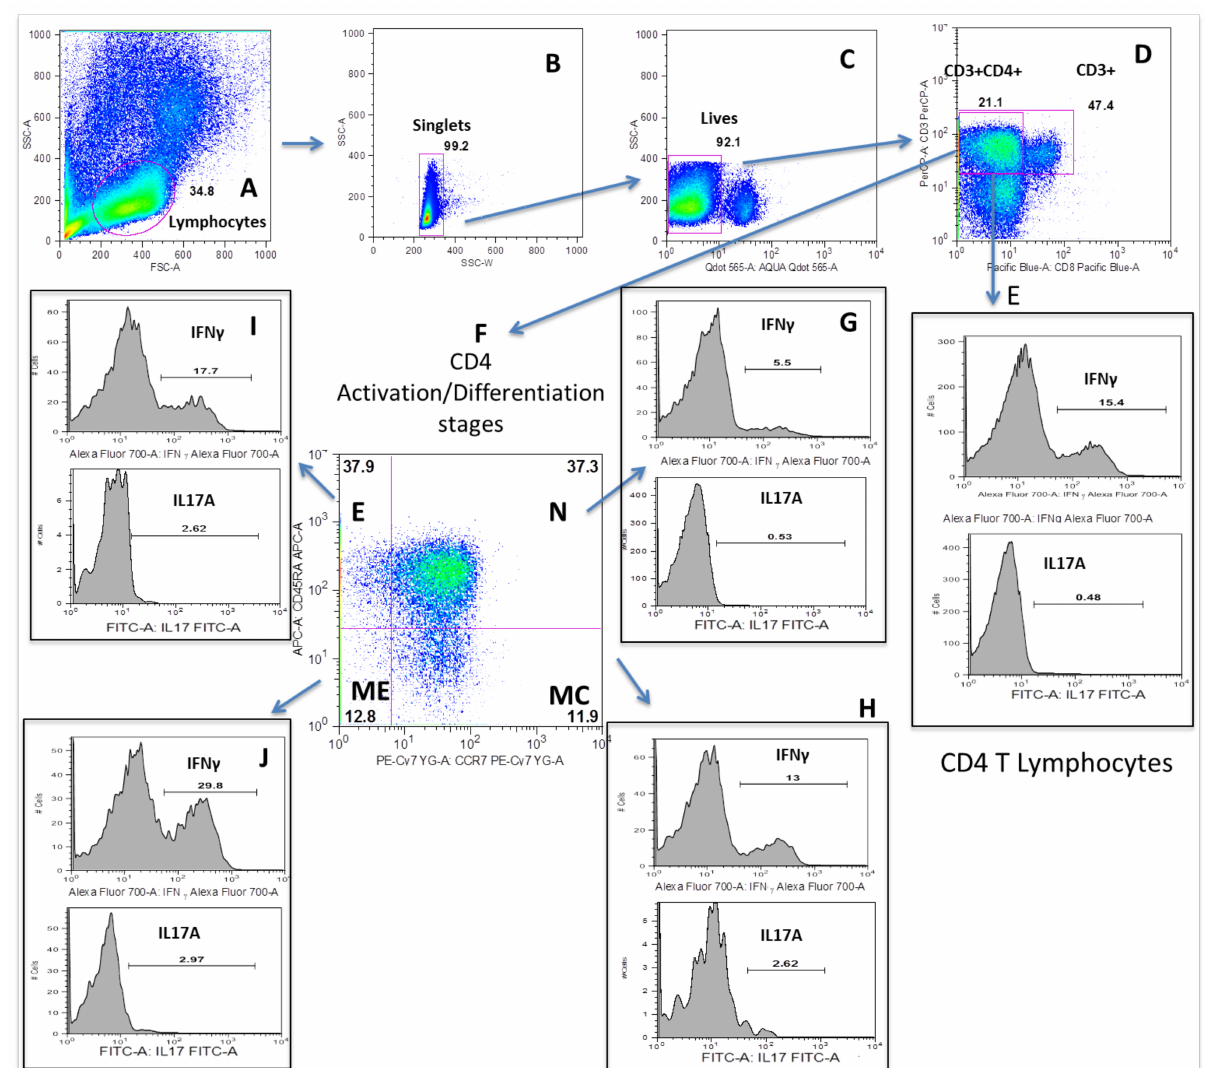
Figure 1. Dot plots represent the flow cytometry gating strategy and histograms of the intracellular interleukin (IL)-17A, interferon (IFN) γ , tumor necrosis factor alpha (TNF-alpha) and IL-4 expression by total circulating CD4 + T lymphocytes and T N , T CM , T EM and T E subsets in a representative case of MDD. The first row of dot plots represents the selected gates and percentages to obtain the total CD4 + T lymphocytes and T N , T CM , T EM and T E subsets in the presence of PMA (50 ng/mL) stimulation for 4 h. Histograms represent the percentages of IL-17A, IFN γ , TNF-alpha and IL-4 producing cells in the indicated CD4 + T lymphocytes subsets. Gating strategy: ( A ) Selection of lymphocytes by size (FSC) and complexity (SSC). ( B ) Exclusion of doublets. ( C ) Exclusion of dead cells. ( D ) Negative selection of CD4 + T lymphocytes using CD3 + CD8 - cells. ( E ) Expression of IFN γ and IL-17A in total CD4 + T lymphocytes. ( F ) Analysis of the activation/differentiation states of CD4 + T lymphocytes. ( G – J ) Expression of IFN γ and IL-17A in T N , T CM , T EM and T E